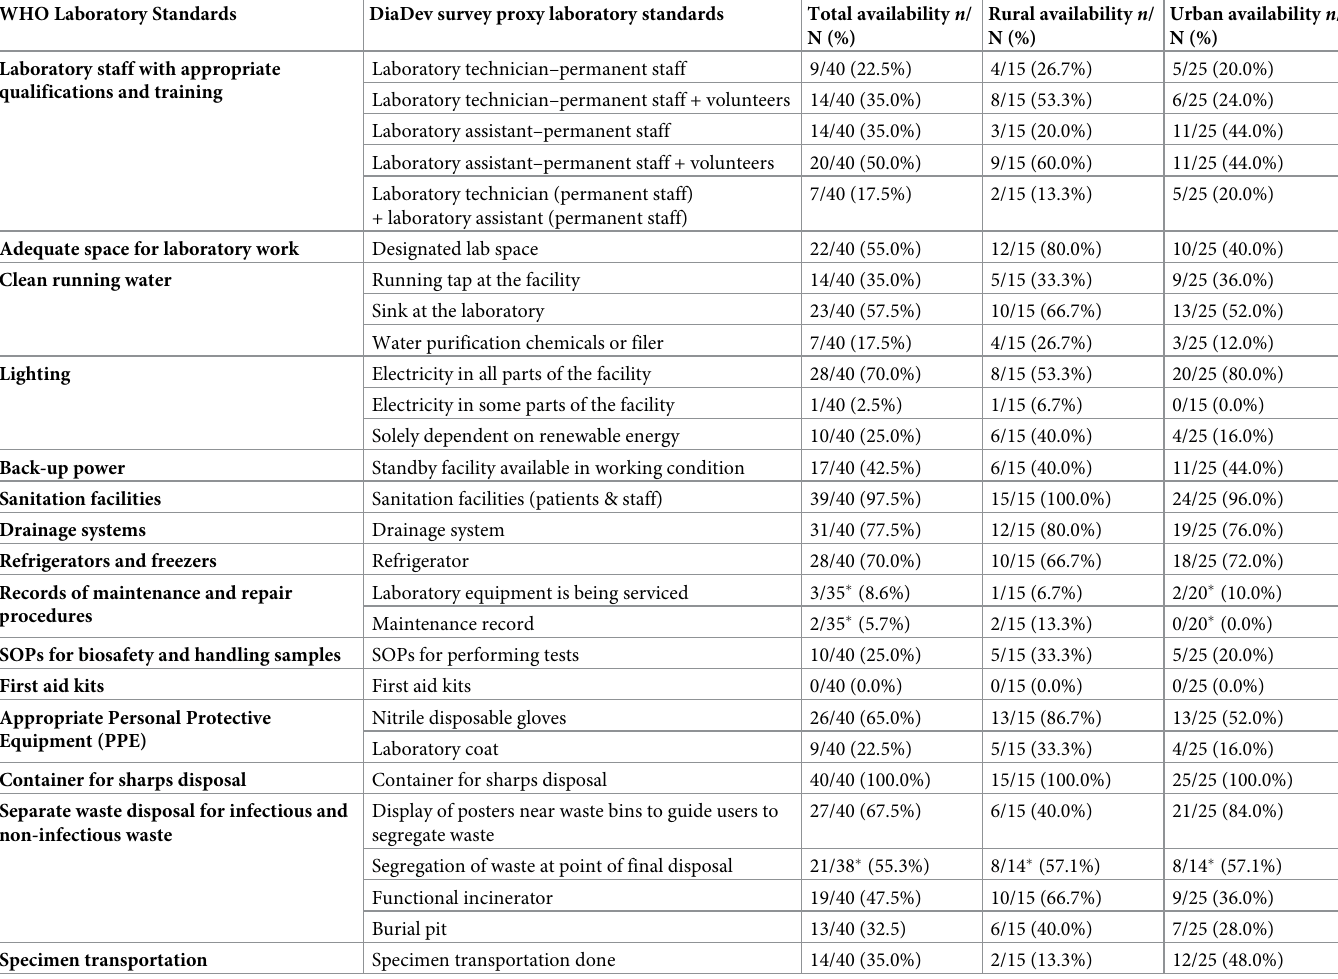
Table 2. Availability of laboratory infrastructure and human